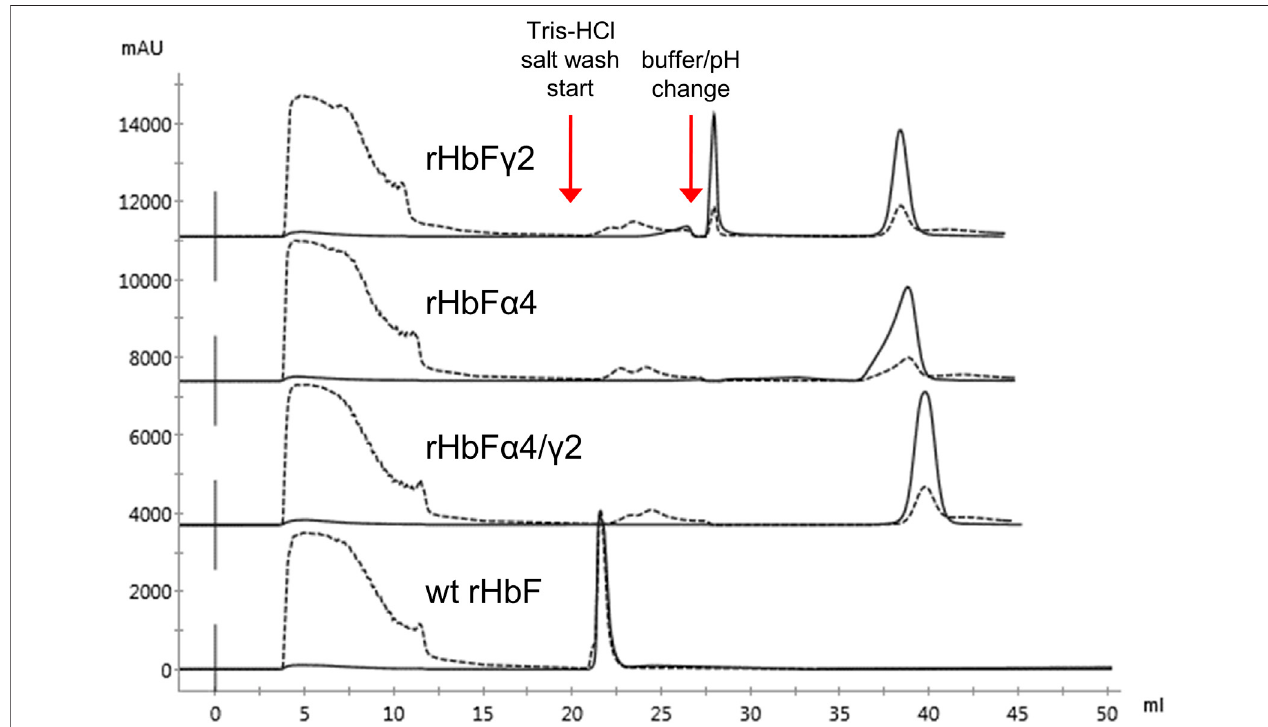
FIGURE 5 | Chromatograms of TREN puri fi cation using the pH switch method described previously of wt rHbF, rHbF α 4, rHbF γ 2, and rHbF α 4/ γ 2. The rHbF γ 2 mutant displayed two strong Hb peaks, one during the pH switch step and the other during the fi nal NaCl elution step, while rHbF α 4 and rHbF α 4/ γ 2 eluted as one peak fraction at the fi nal elution. The wild-type protein eluted with several contaminating proteins during the fi rst NaCl wash. Solid lines indicate the 419 nm UV trace and the dashed lines indicate 280